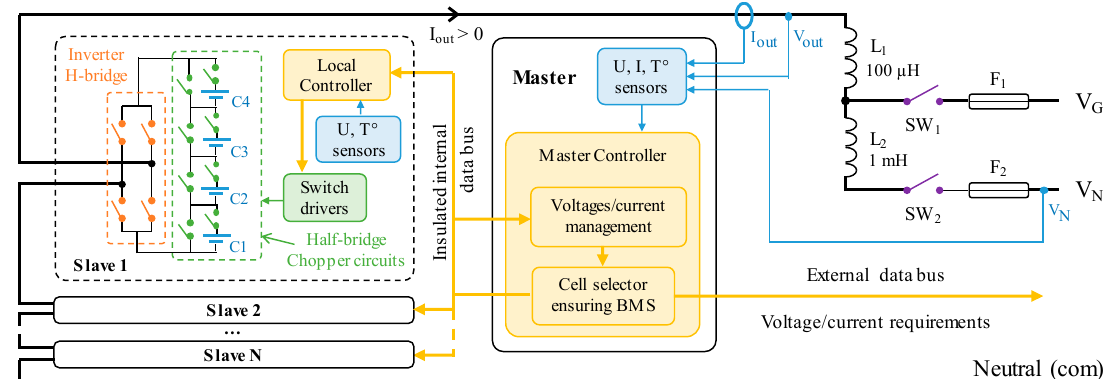
Figure 2. On the fly cells switch principle.